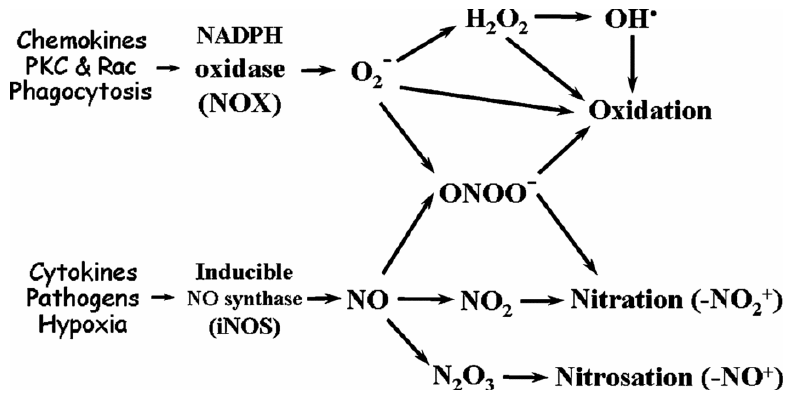
FIGURE 4. Generation and interaction of ROS and